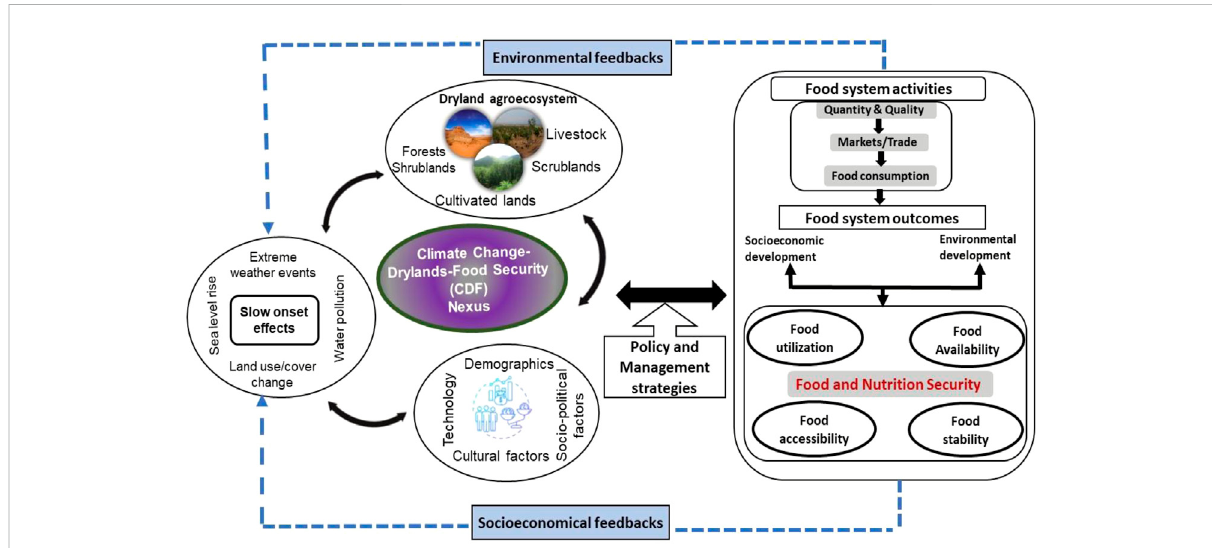
FIGURE 3 Interrelationship among the dryland agroecosystem, climate system, socio-economic system, and food system. Here, we present the CDF nexus (epicenter) from the viewpoint of environmental and socioeconomic feedback (above and below) and food system outcomes (right side). In particular, the anthropogenic activities, natural processes, and socioeconomic operations together drive dryland agroecosystem changes in African drylands. All these combined factors, however, positively/negatively impact the stability and income level, via effects on productivity, production costs, and market prices resulting in food insecurity and malnutrition.